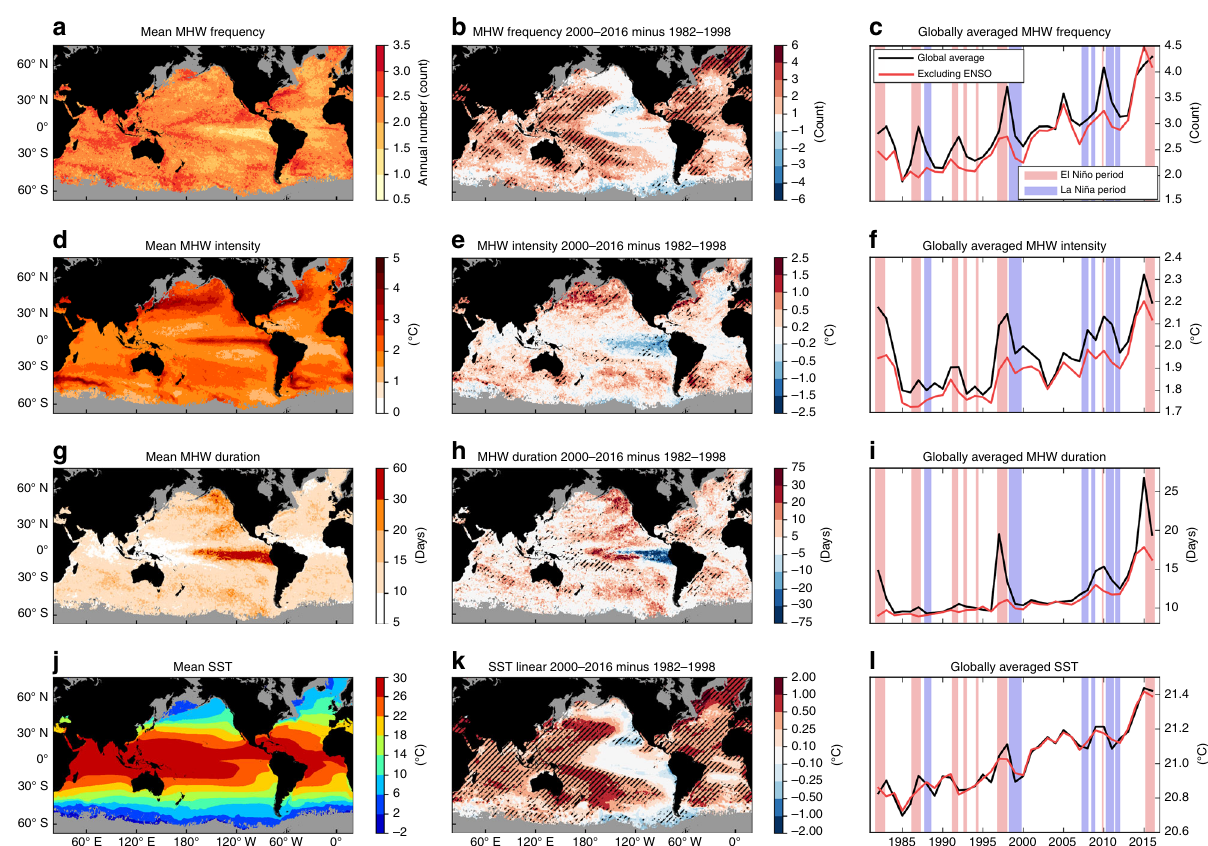
Fig. 1 Global sea surface temperature and marine heatwave properties. a , d , g , j Mean over the 1982 – 2016 period, b , e , h , k difference between the 1982 – 1998 and 2000 – 2016 periods, and c , f , i , l globally averaged time series of annual mean a – c marine heatwave (MHW) count, d – f MHW intensity, g – i MHW duration and j – l SST from NOAA OI SST over 1982 – 2016. In b , e , h and k , hatching indicates the change is signi fi cantly different from zero at the 5% level. In c , f , i and l , the black lines show the globally averaged time series and red lines show a global average after removing the signature of ENSO. In c , f , i and l , the light red and blue shading indicate El Niño and La Niña periods, respectively, de fi ned by periods exceeding ±1 s.d. of the MEI index for at